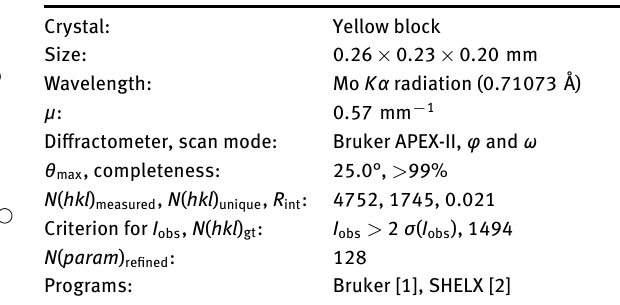
Table 1: Data collection and handling.